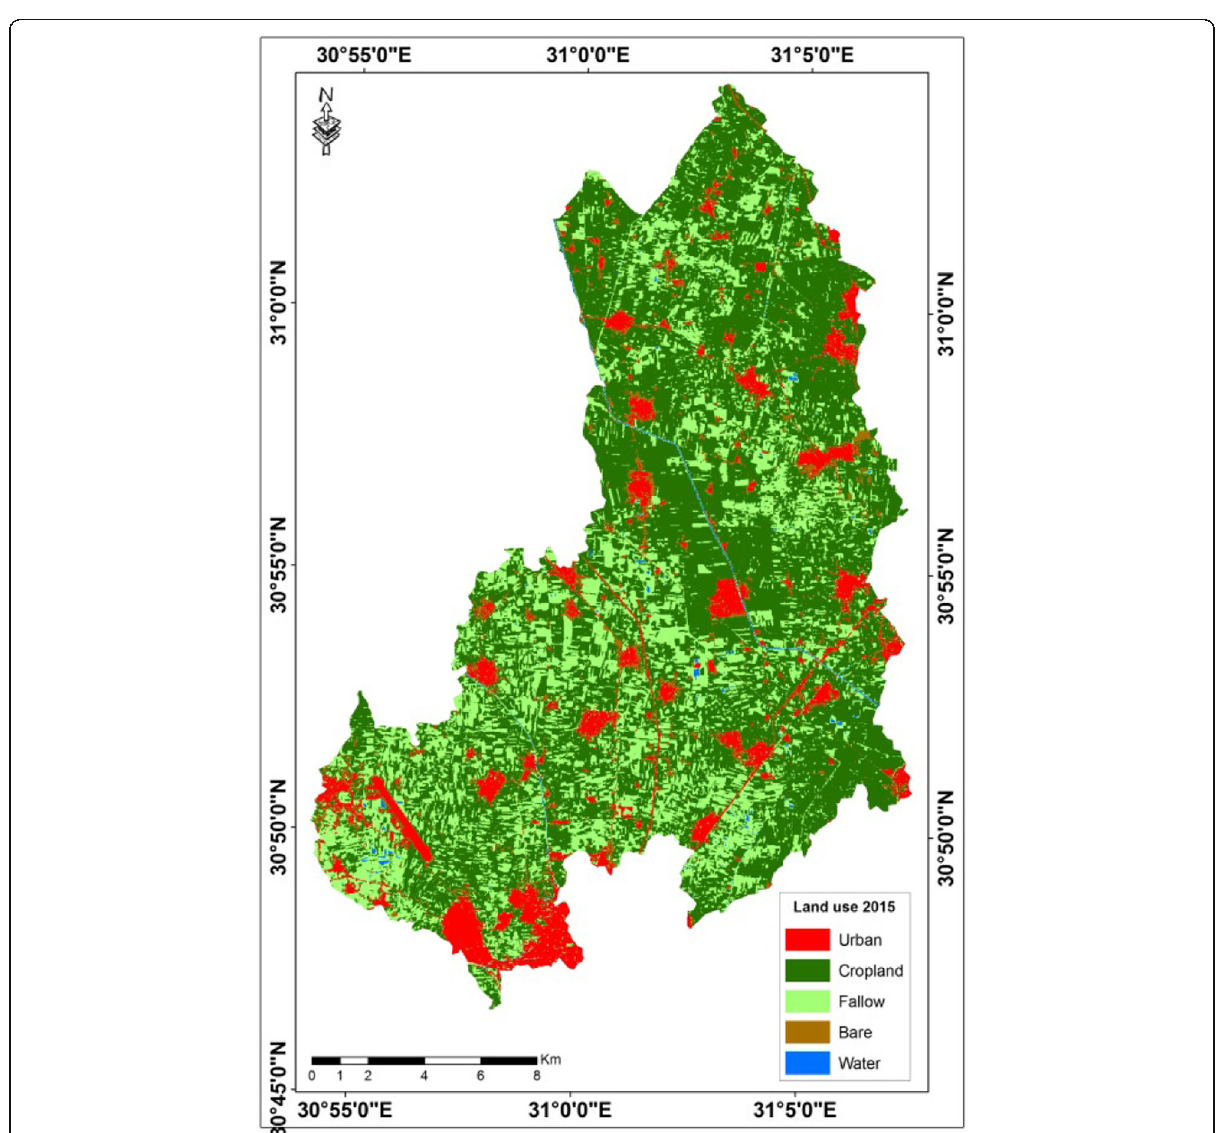
Fig. 3 Land-use types at the catchment